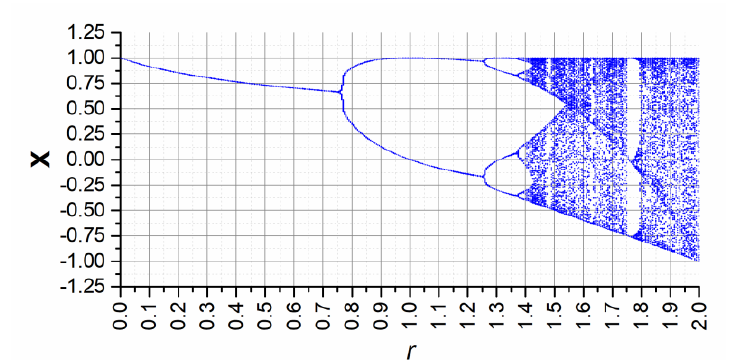
Figure 3. The bifurcation diagram of the logistic mapping (2).